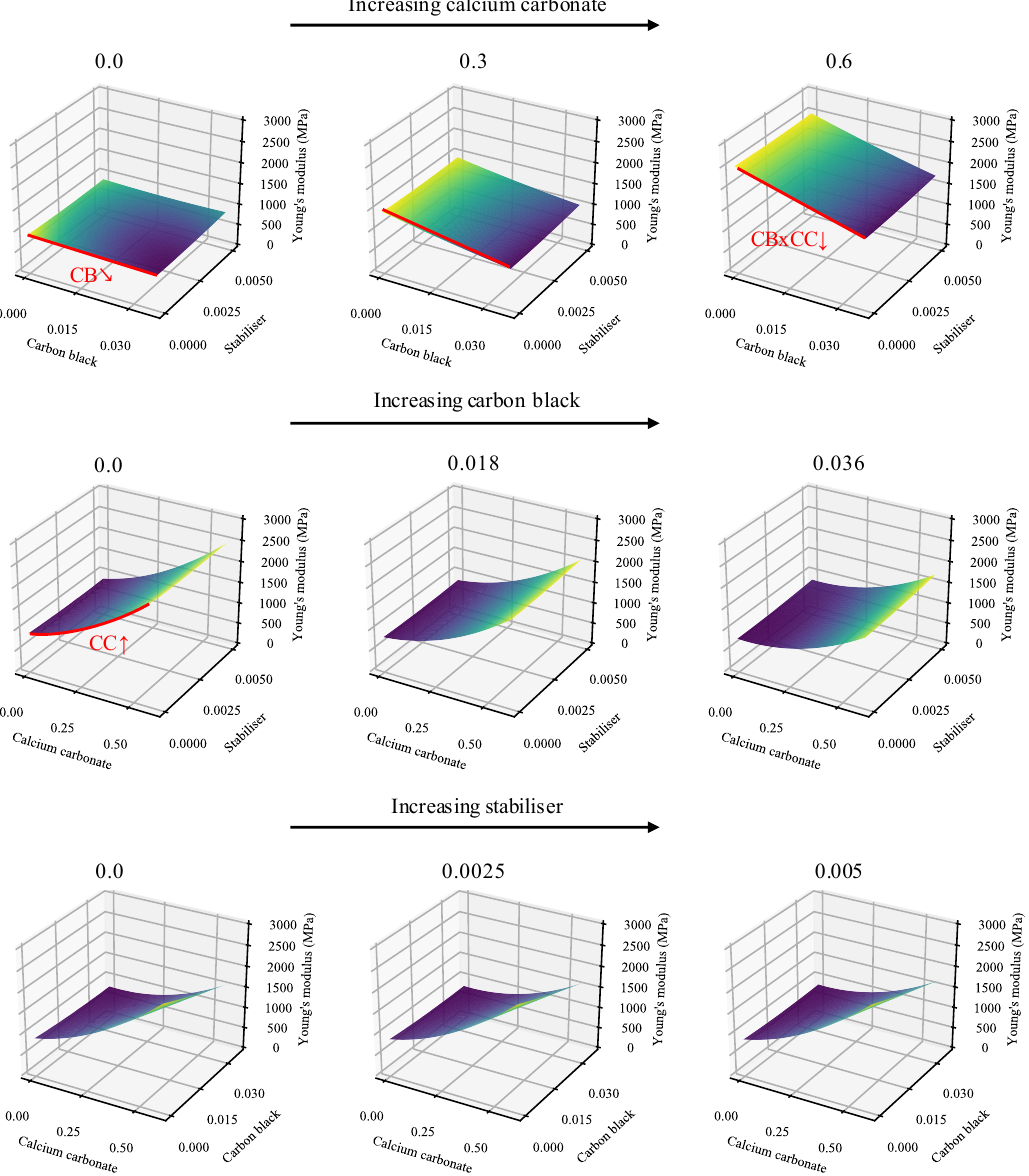
Figure 3. Weld-line Young’s modulus model predictions. Here, note particularly the very strong positive effect of increasing CC loadings, increasing with increasing CC loading, and the slightly negative primary effect of increasing CB loadings at 0-CC, becoming increasingly negative with greater CC